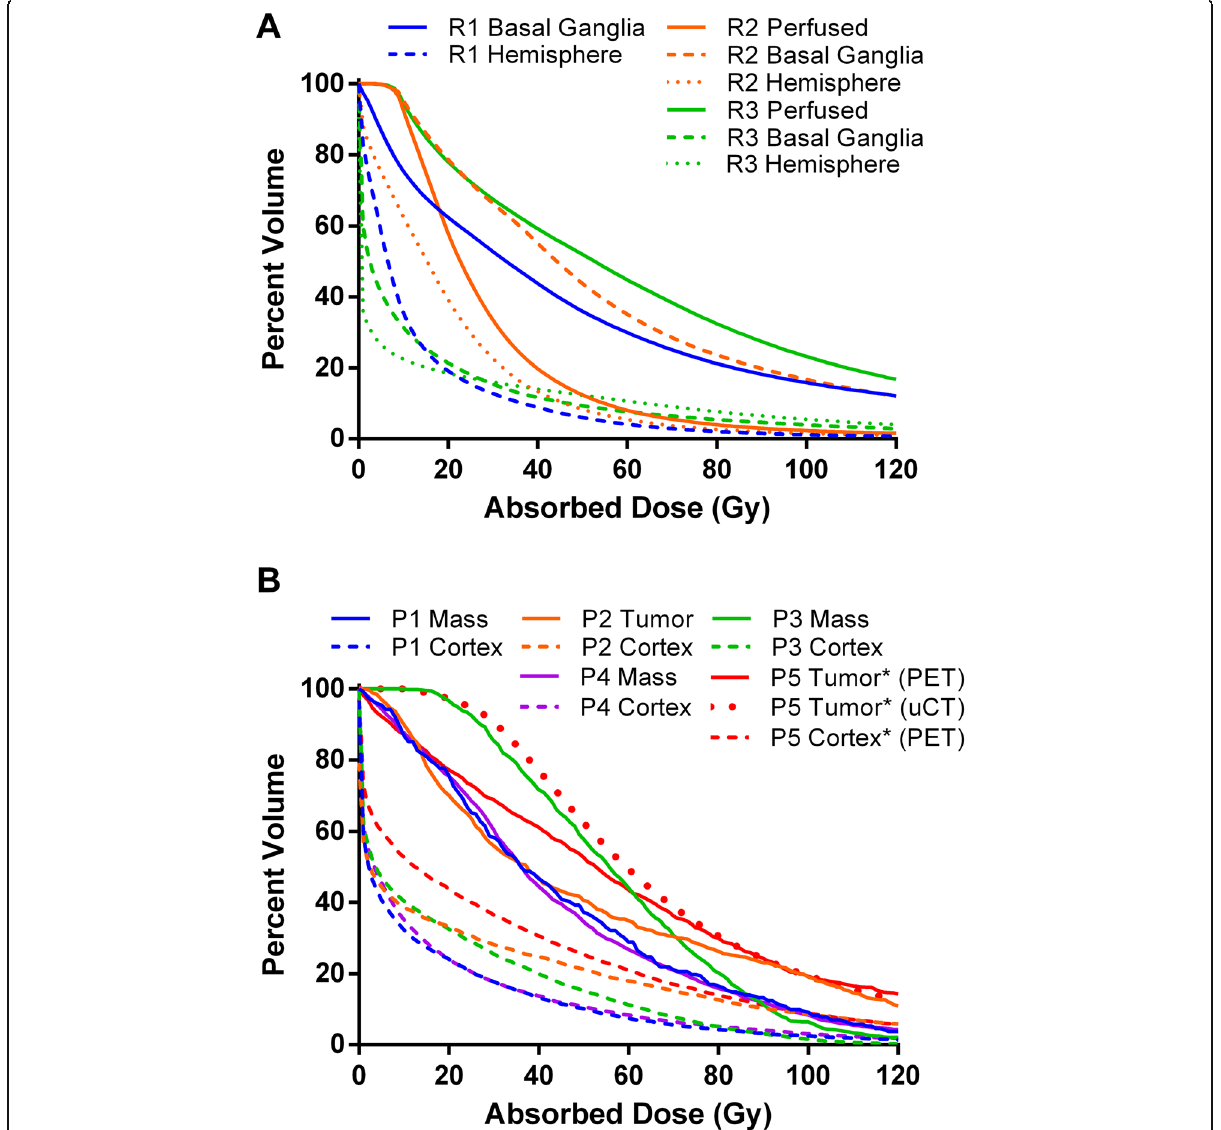
Fig. 5 Dose-volume histograms. a R1-R3 based on microCT identification of microspheres in the treated hemisphere after euthanasia and organ extraction. b P1 – P5 based on post-infusion quantitative 90 Y PET/CT. MicroCT-based dose-volume histogram is also provided for P5 post-mortem. *P5 values are extrapolated assuming this animal had survived. For actual dose delivered, see Table